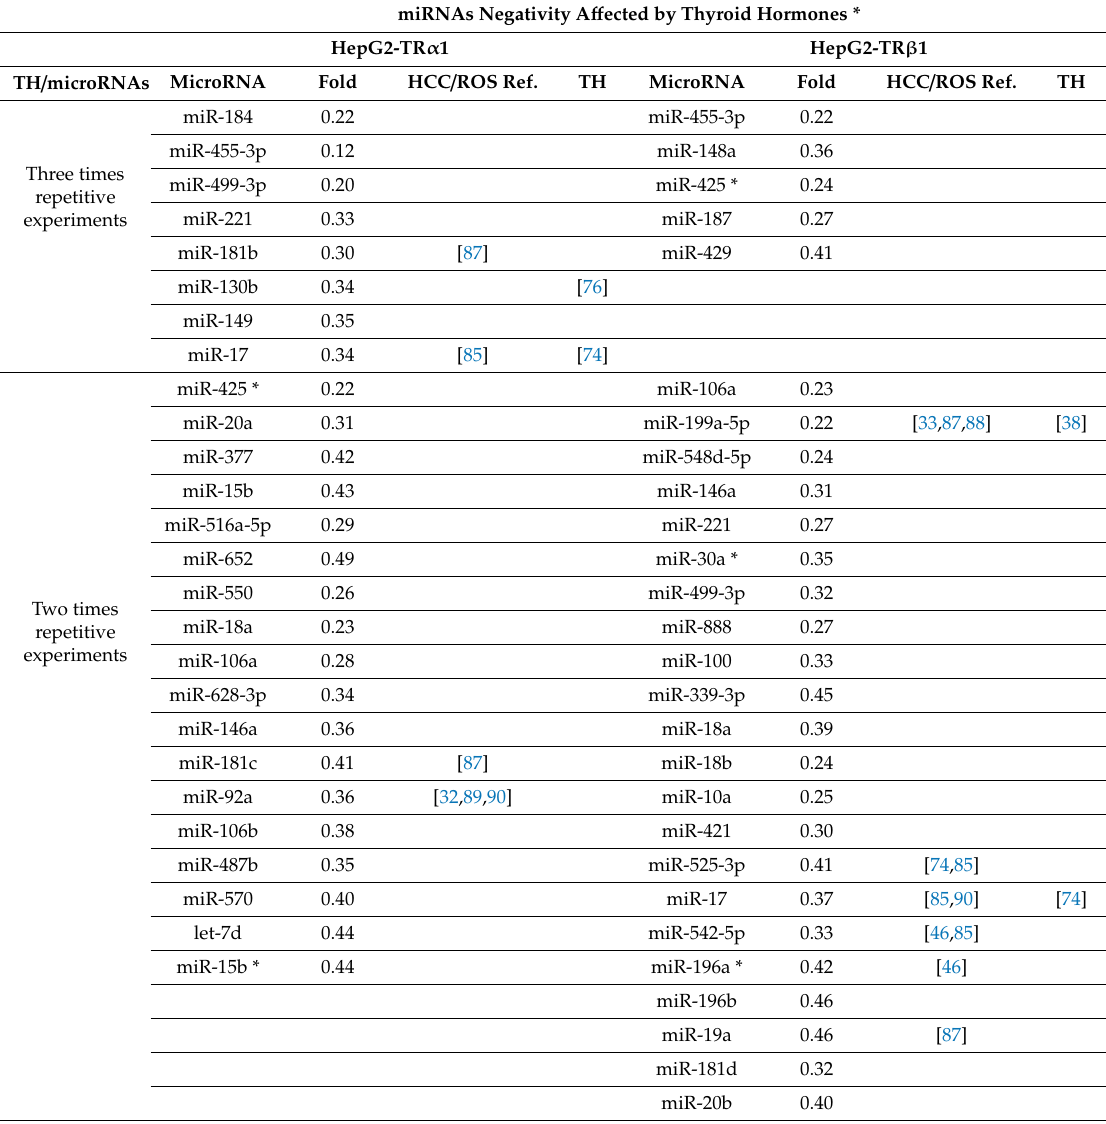
Table 3. MicroRNAs negativity associated with thyroid hormones in HepG2 liver cancer cell lines. miRNAs Negativity A ff ected by Thyroid Hormones * HepG2-TR α 1 HepG2-TR β 1 TH / microRNAs MicroRNA Fold HCC / ROS Ref. TH MicroRNA Fold HCC / ROS Ref.